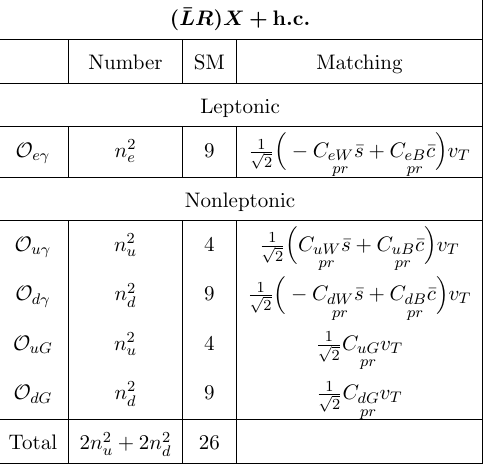
Table 11 . Dimension-five (¯ LR ) X dipole operators in LEFT. There are also Hermitian conjugate dipole operators ( ¯ RL ) X , as indicated in the table heading. The operators are divided into the leptonic and nonleptonic operators. The second column is the number of operators for an arbitrary number of charged lepton flavors n e , u -type quark flavors n u , and d -type quark flavors n d , and the third column is the number in the SM LEFT with n e = 3, n u = 2 and n d = 3. The last column is the tree-level matching coefficient in SMEFT. ¯ s and ¯ c are defined in eq. (